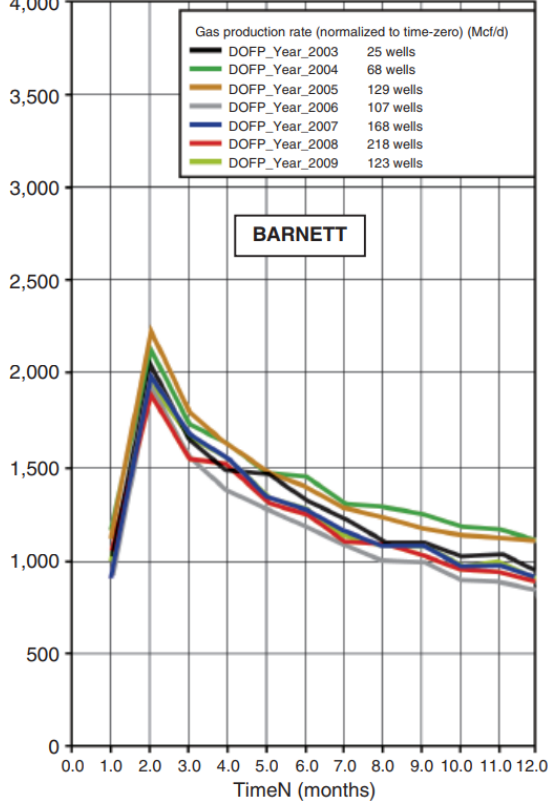
Figure 20—Barnett shale first-year production